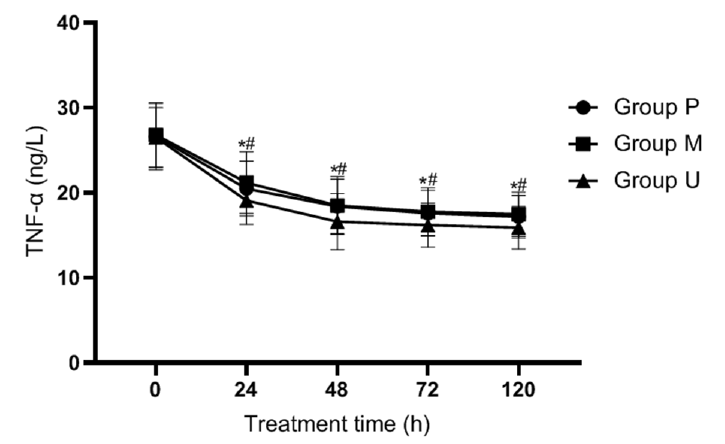
FIGURE 3 - Comparison of TNF-α levels among the three groups at different treatment times. *P < 0.05 compared with group P at the same time point; #P < 0.05 compared with group M at the same time